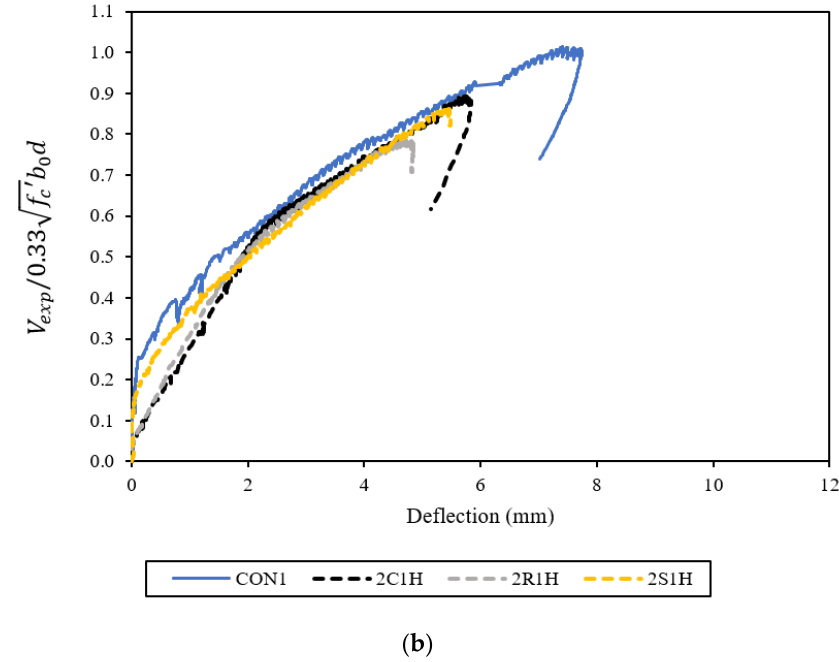
Figure 14. Normalized load-displacement curves ( a ) Openings at 4H ( b ) Openings at 1H.